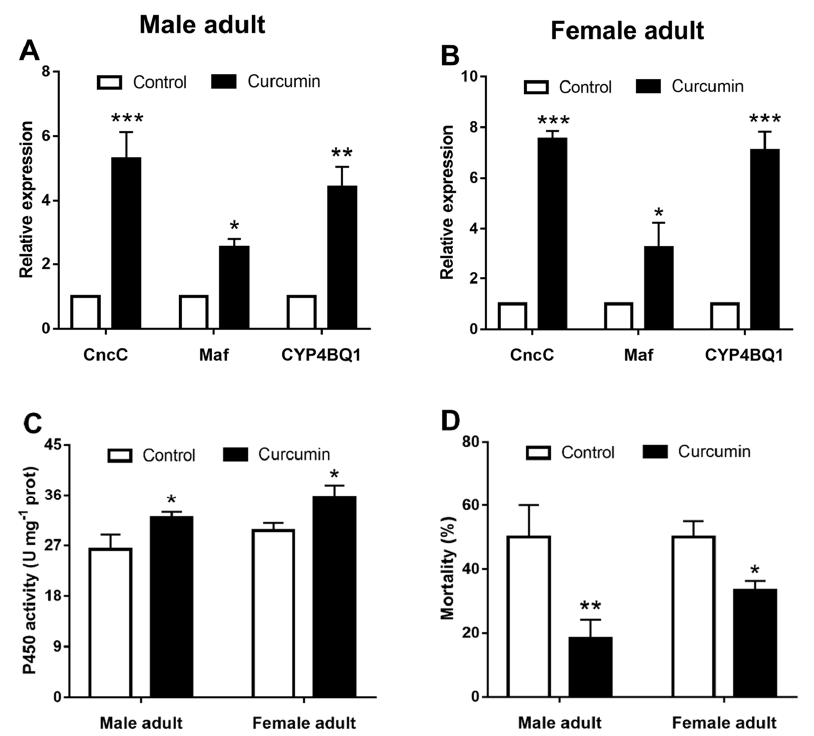
Figure 8. Activation of CncC pathway by the curcumin induces the expression of CYP4BQ1 and enhances adults’ tolerance to (+)- α -pinene. Adults were treated with the CncC agonist curcumin for 48 h. The relative expression levels of CncC, Maf , and CYP4BQ1 ( A , B ) were detected by RT-qPCR. The activities of P450 ( C ) in the midgut of adults were determined spectrophotometrically. ( D ) Cur- cumin-treated adults were then exposed to (+)- α -pinene, and mortality was assessed after 24 h. The asterisk indicates a significant difference between treatment groups (* p < 0.05, ** p < 0.01, *** p < 0.001, independent Student’s t -test). All values are the mean ± SE, n = 3. 3. Discussion Several previous studies have indicated that CYPs are the main metabolic detoxifica- tion enzymes, which participate in the detoxification of pesticides and the development of resistance of insect populations [29–31]. Insect CYP genes belong to many CYP subfam- ilies, and their expression patterns in different tissues and developmental stages are sig- nificantly different, which provides important clues for their physiological functions [32,33]. In this study, survey of different stages indicated that the transcript of CYP4BQ1 was expressed at all developmental stages of D. armandi . Among these, CYP4BQ1 was ex- pressed the highest in the adult stage, followed by the larval stage. In insects, CYP4 family members are thought to participate in the biosynthesis of endogenous complexes [34,35] and the metabolism of pheromones [36,37], in addition to insecticide/phytochemicals re- sistance, which suggests that CYP4BQ1 may participate in some physiological processes regulating the development and growth of beetles. In addition, the expression of CYP4BQ1 was further investigated in various tissues of adults, suggesting that it was ex- pressed predominantly in the midgut and fat body. As a dynamic tissue, the fat body participates in various metabolic functions, playing a key role in the insect metabolism [38]. The midgut not only is the place where insects digest and absorb, but also has the